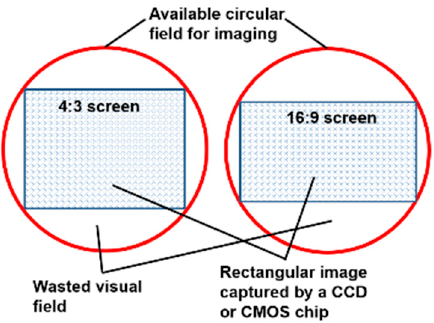
Figure 2. A rectangular image sensor chip is placed within a circular field in the image plane, capturing only part of the useable visual field.